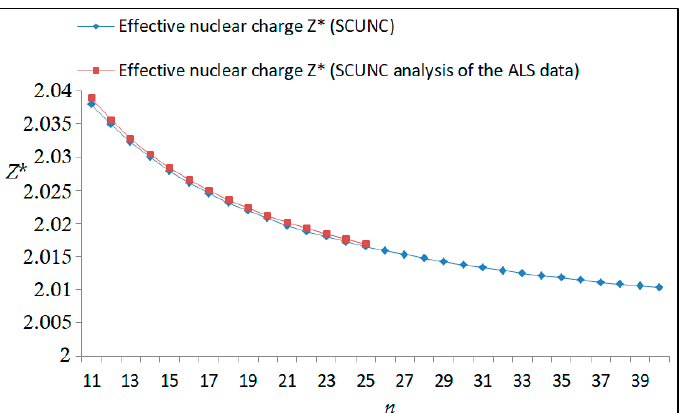
Figure 24. Variations of the effective nuclear charge Z* with the principal quantum number n for the 4 s 2 4 p 2 ( 1 D 2 ) ns ( 2 D ) Rydberg series originating from 2 S ° 3/2 metastable state of Se + converging to the 3 P 2 series limits in Se 2+ .